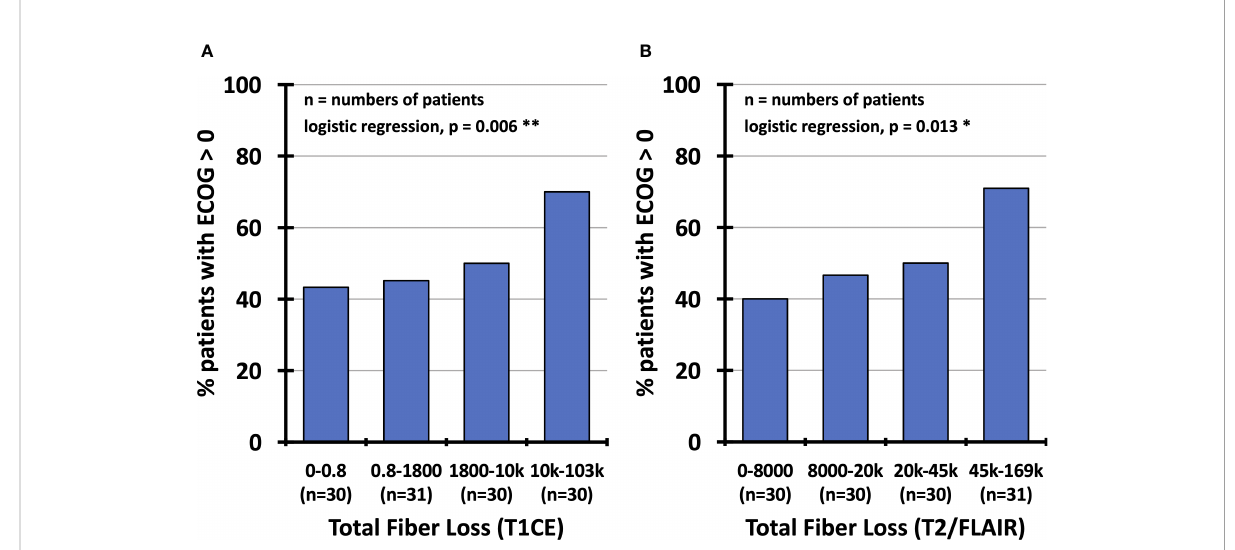
FIGURE 8 Percentage of patients with impaired performance status (ECOG score ≥ 1) depending on total fi ber loss (1 – (patient fi ber density/reference fi ber density) multiplied by lesion volume), partitioned into quartiles of observed values con fi ned to contrast-enhancing lesions (A) and hyperintense T2/FLAIR regions (B) . ECOG, Eastern Cooperative Oncology Group; T1CE, T1-weighted contrast-enhancing; T2/FLAIR, T2-weighted fl uid- attenuated inversion